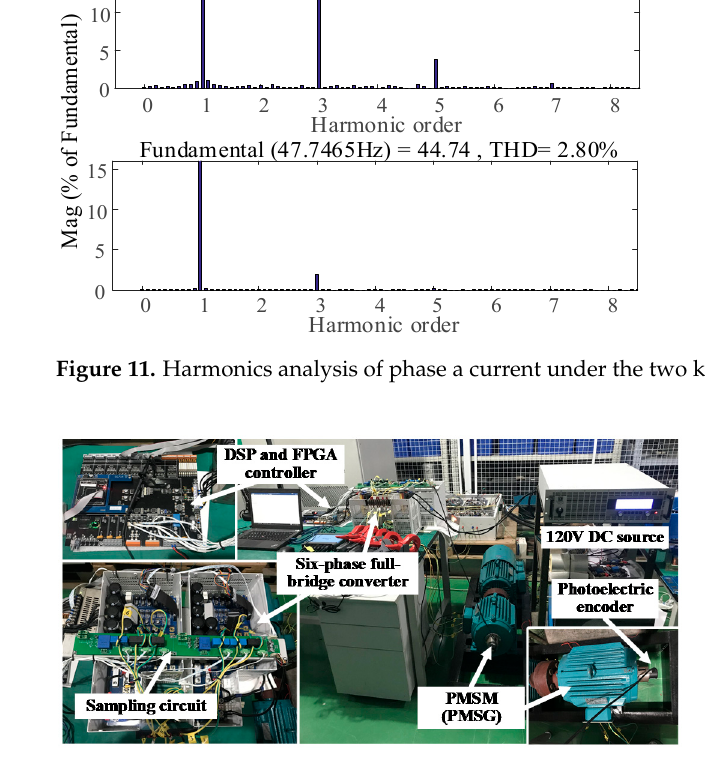
Figure 12. The PMSM experimental system.